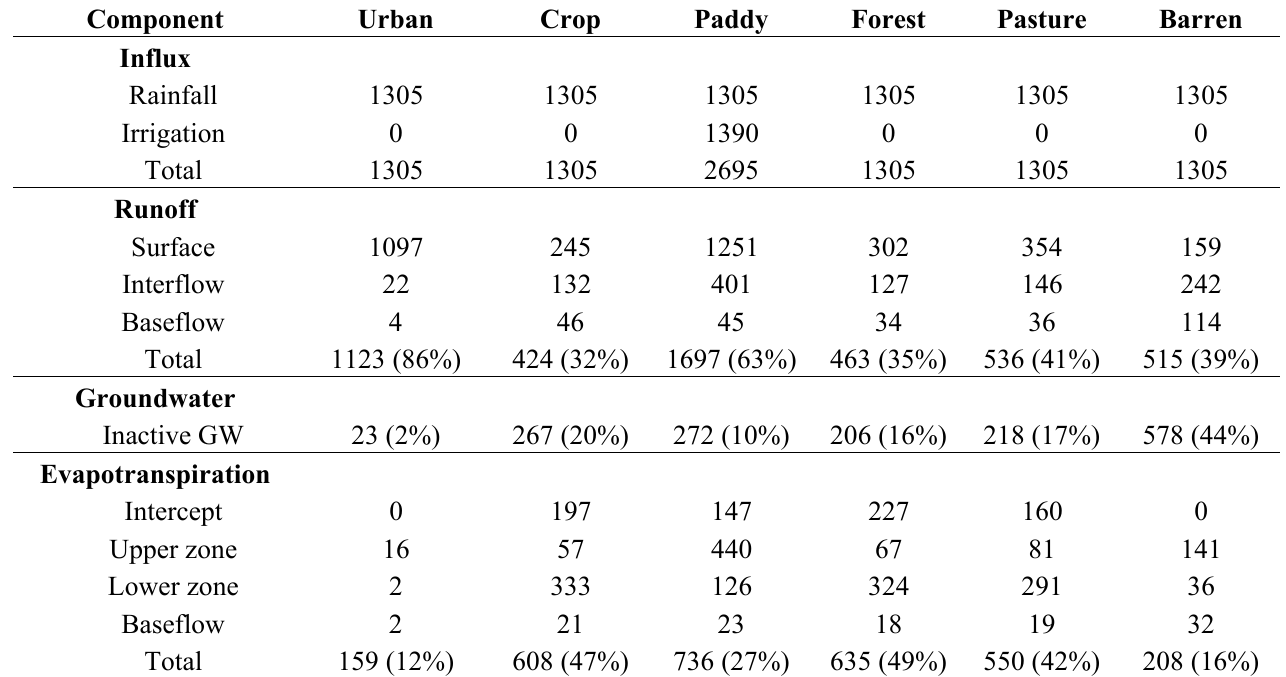
Table 8. Comparison of water budget components by land use for simulation period (mm). Component Urban Crop Paddy Forest Pasture